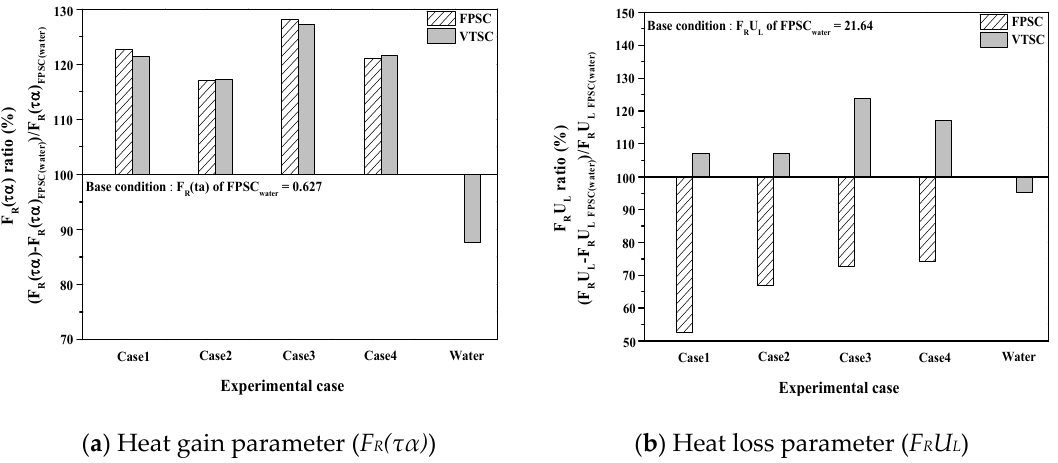
Figure 6. F R ( τα ) and F R U L ratio of a solar collector using water and MWCNT/Fe 3 O 4 nanofluid.